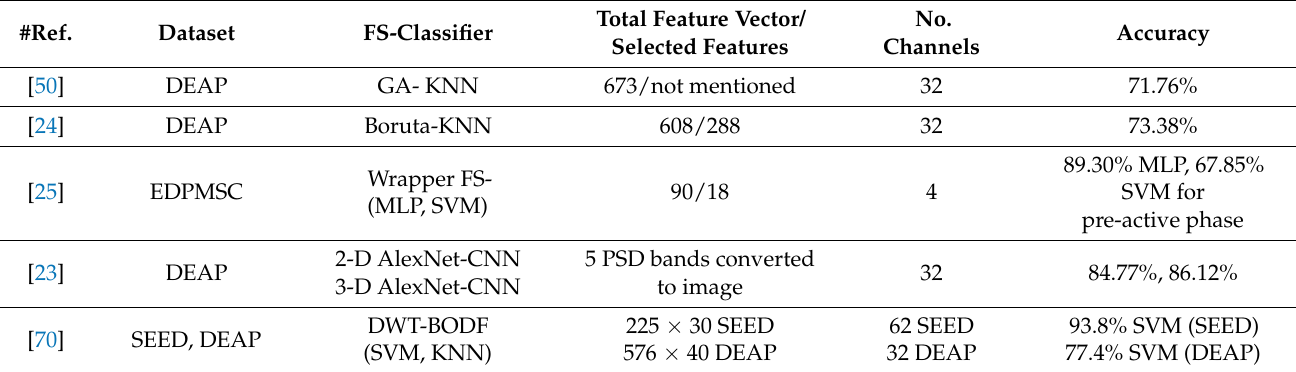
Table 4. Comparison with previous studies on related publicly available datasets for mental stress detection.